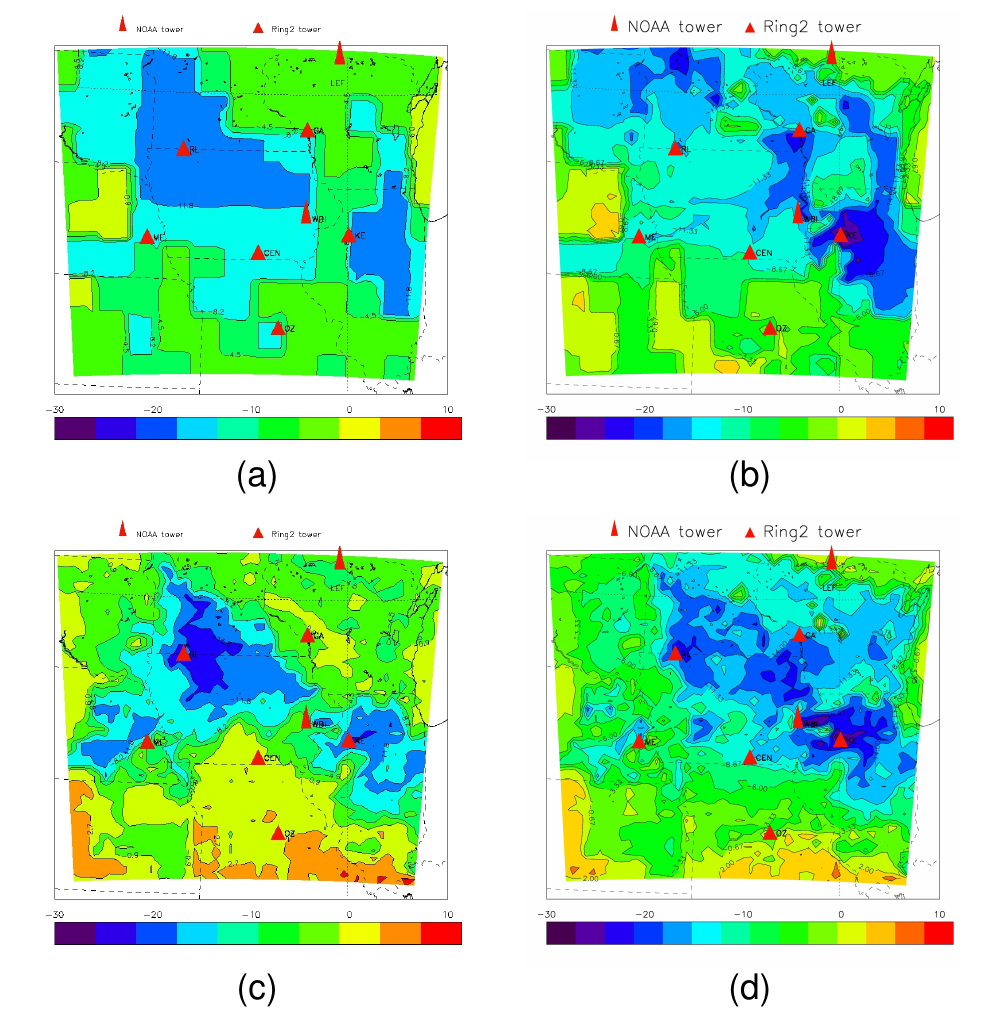
Fig. 9. Map of the CO 2 fluxes accumulated from June to December in TgC.degree − 2 over the MCI using CarbonTracker2009 inverse fluxes as prior: (a) prior and (b) posterior fluxes; and direct flux estimates from SiBcrop as prior fluxes: (c) prior fluxes and (d) posterior fluxes.